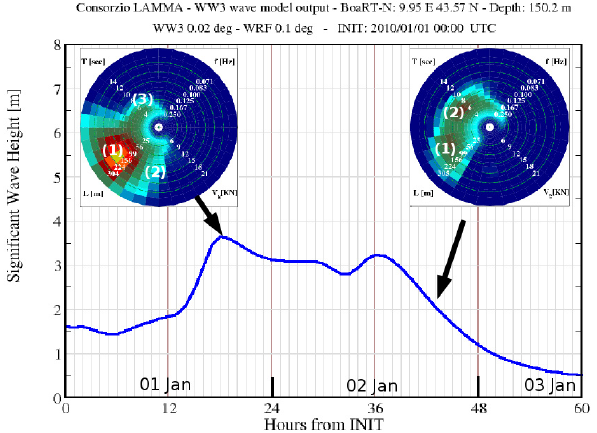
Figure 6. SWH (m) wave model forecast time-serie for the RT buoy location valid for the period from 00:00UTC on 1 January to 12:00UTC on 3 January 2010. Upper left: directional wave spec- trum forecast for 18:00UTC on 1 January as indicated by the black arrow. Upper right: same as upper left, but for 12:00UTC on 2 Jan- uary